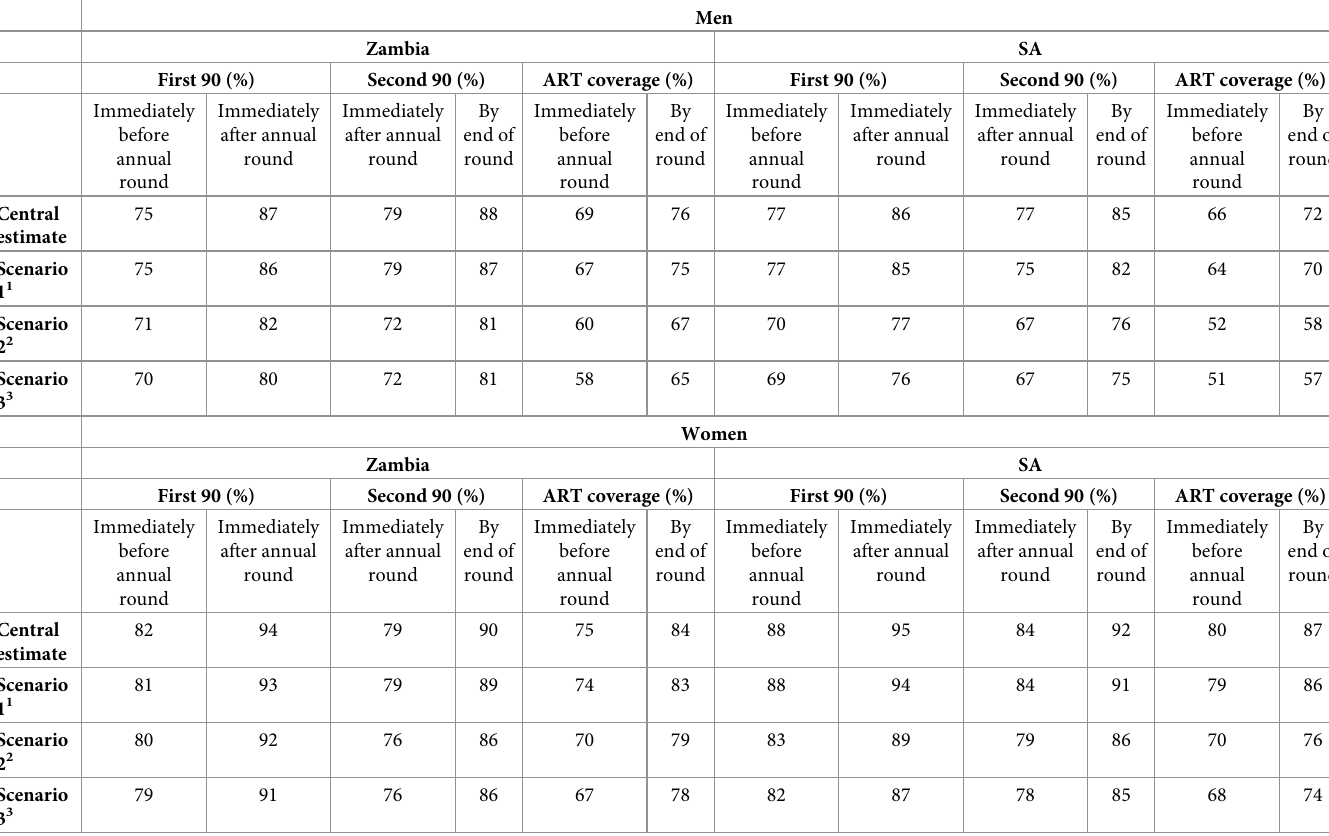
Table 4. Arm A, R3: Sensitivity analysis of estimates of ART coverage and estimates of coverage against the first and second 90 targets: Example “conservative”